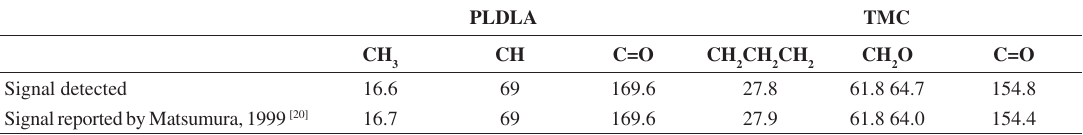
Table 3. 13 C-NMR signals for PLDLA and TMC.